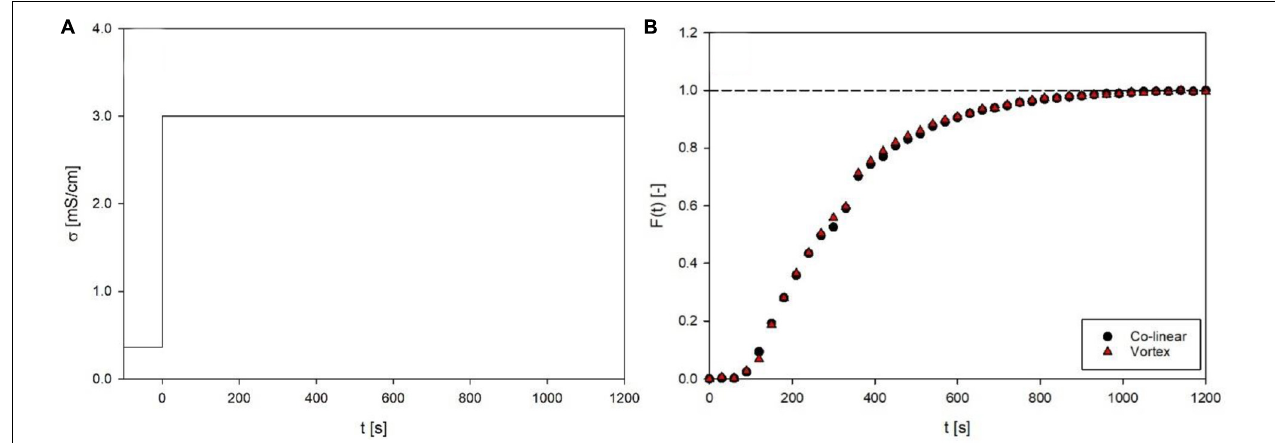
FIGURE 5 | Inlet function (A) and response function (B) of the residence time distribution for co-linear and vortex chambers at a flow rate of 7 L/h. Given are electrical conductivity ( σ ) and the calculated dimensionless residence time function F ( t ) over time. Data points depict the average of three independent replicates.